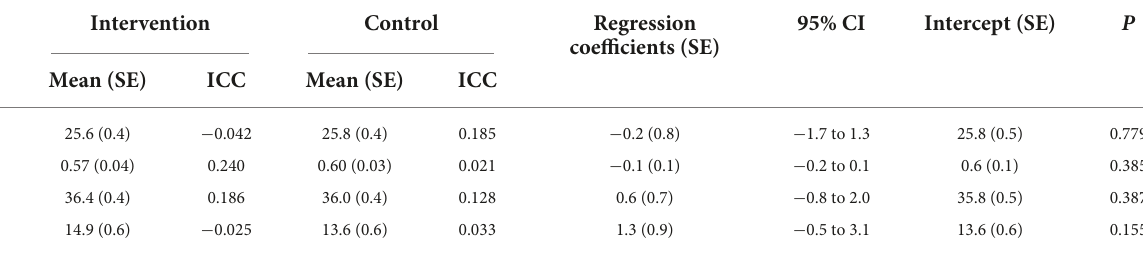
TABLE 3 Comparison of secondary outcomes after first visits.